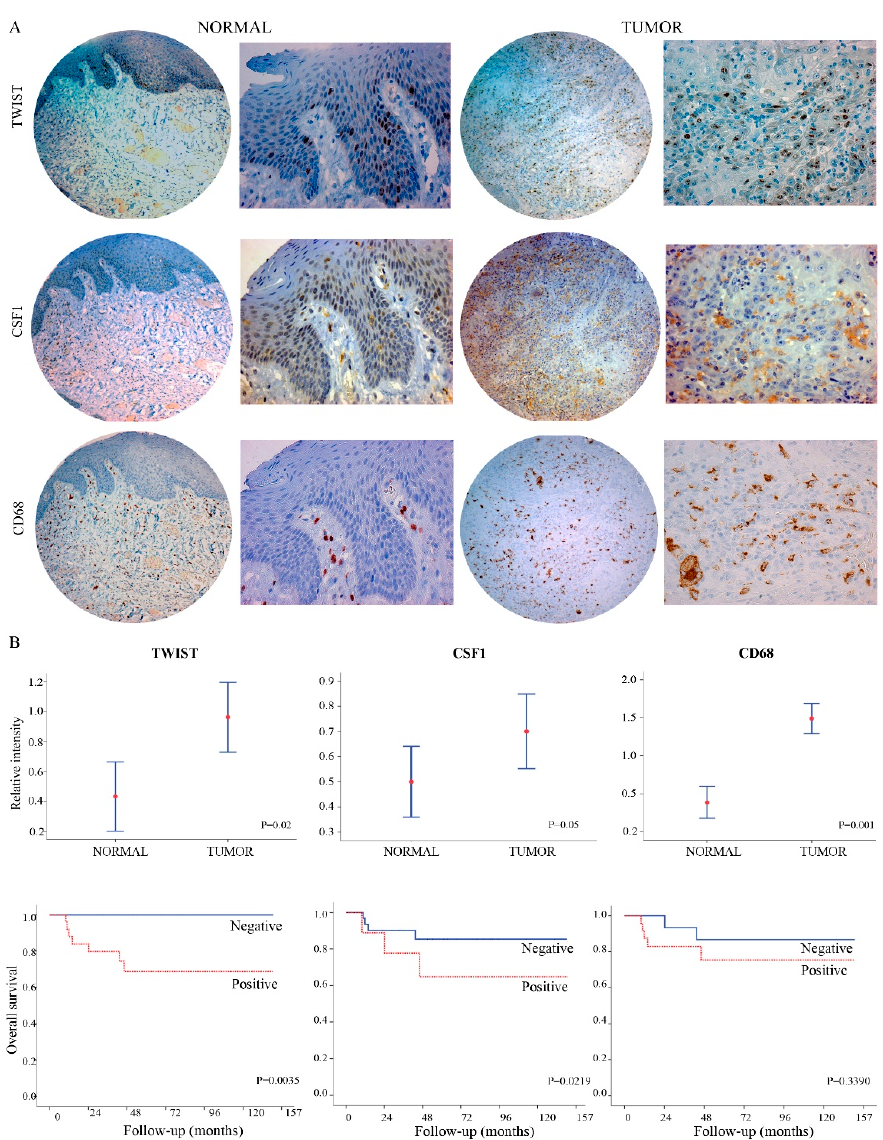
Figure 2. TWIST1 and CSF1 can predict oral cancer progression to metastasis and poor outcomes. ( A ) Immunohistochemistry images of TWIST1, CSF1 and CD68 proteins expression in normal (left side) and oral cancer samples (right side). A negative or weak staining was observed in morphologically normal tissues while a strong nuclear staining (for TWIST1) and cytoplasmic staining (for CSF1 and CD68) was detected in OSCC samples. Magnification of 50× (circle in the left) followed by enlarged area of the image with 200× (square in the right). ( B ) TWIST1, CSF1 and CD68 proteins were differ- entially expressed in non-metastatic and metastatic OSCC patients as well as in non-cancer tissues. Confidence intervals (CI: 95%) show relative percentage and IHC intensity value. Y-axis represents numerical values corresponding to the per- centage and intensity of expression. The bottom graphs represent the Kaplan-Meier overall survival analysis showing a significant positive correlation involving survival rate for TWIST1 and CSF1 expression (log-rank test, p = 0.0035, p = 0.0219, respectively) but not CD68 (log-rank test, p = 0.3390). 2.3. TWIST1 Regulates CSF1 Expression in OSCC Cells A panel of oral cancer human cell lines (SCC9, SCC25, and OSCC1.2/RBT3) where TWIST1 is overexpressed or knockdown, as well as normal immortalized oral epithelial cells (NOE) established from human tongue, were investigated as a preclinical model. NOE cells undergo EMT upon stimulation by TGF β (Figure 3A). In comparison to the